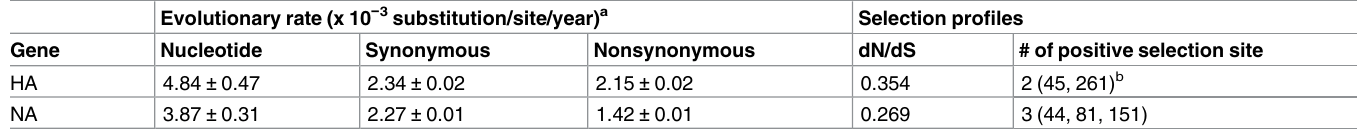
Table 3. Evolutionary rates and selection profiles determined with the HA and NA genes of H3N2strains circulating for the 2009/10-2011/12 seasons. Evolutionary rate (x 10 − 3 substitution/site/year)